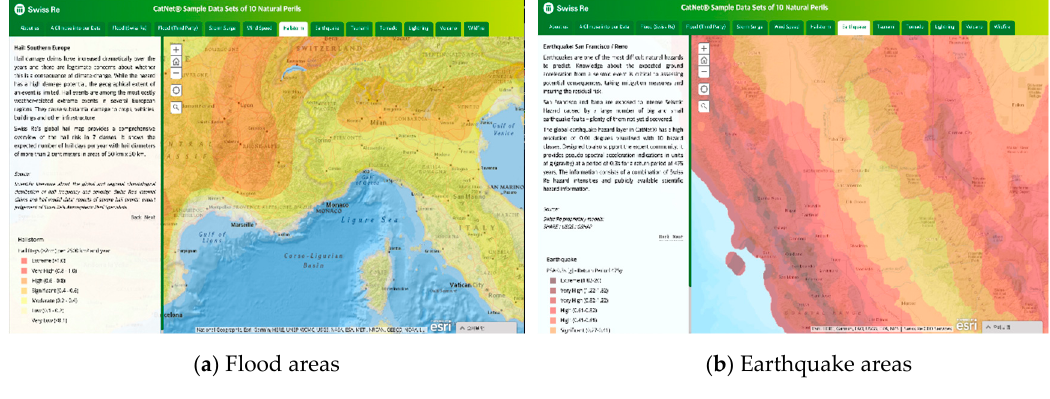
Figure 1. CatNet web map service, Swiss Re.